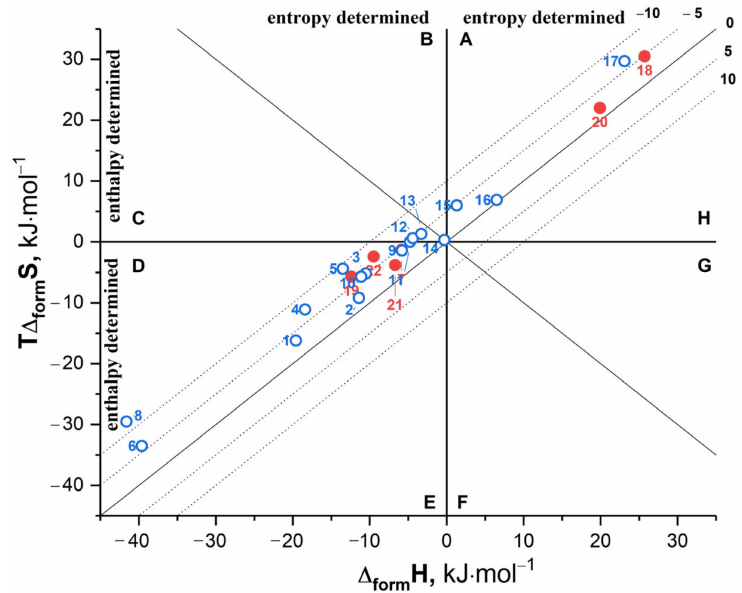
Figure 5. The experimental thermodynamic parameters of cocrystallization processes for 22 systems in terms of entropy vs. enthalpy coordinates. The dotted lines correspond to isoenergetic values of ∆ form G. The red points indicate CBZ cocrystals, whereas the blue ones correspond to cocrystals of various APIs. The numbering is provided in Table